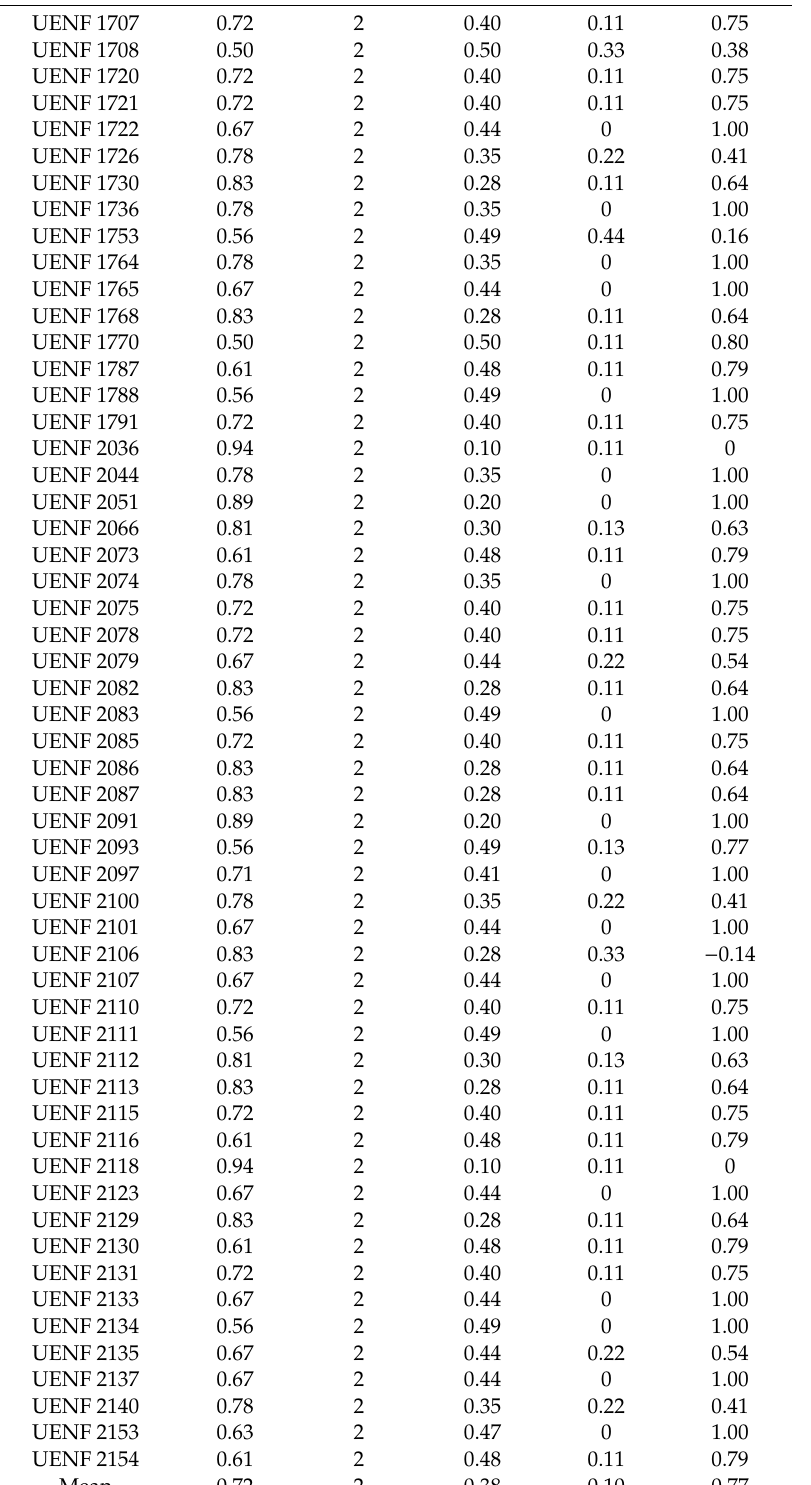
Table 2. Characterization of C. chinense accessions obtained by molecular analysis with microsatellite